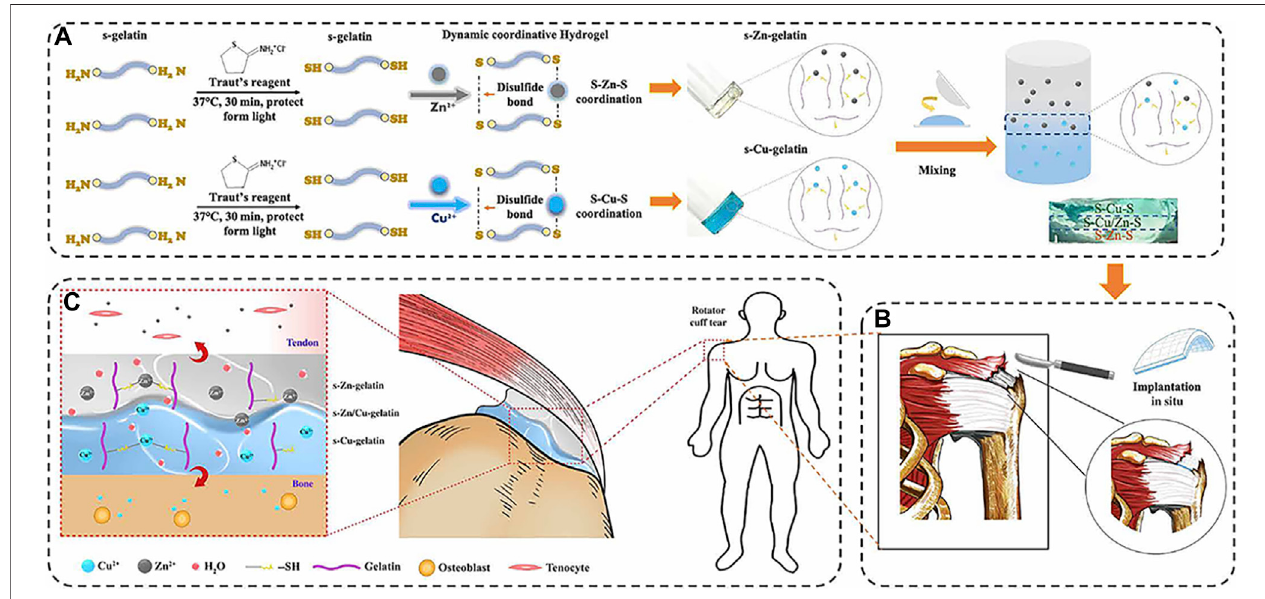
FIGURE 4 | (A) The fabrication of gradient bimetallic hydrogels. (B) The application of the gradient bimetallic hydrogel for RCT. (C) The mechanism of gradient bimetallic hydrogel for the regeneration of tendon-bone interface. (Reprinted from (Yang et al., 2021) with permission from Science